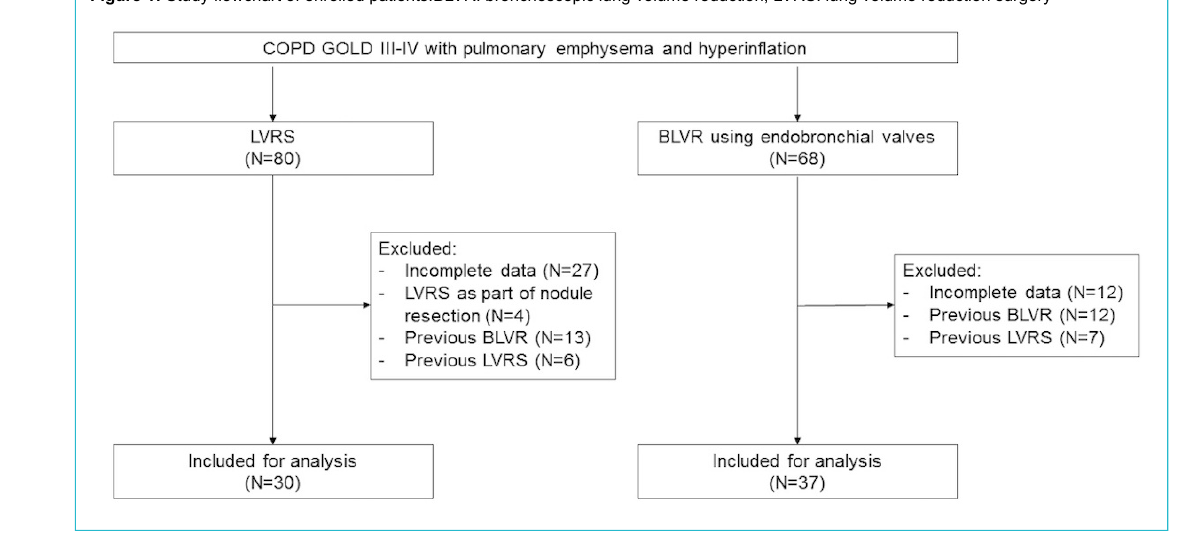
Figure 1: Study flowchart of enrolled patients.BLVR: bronchoscopic lung volume reduction; LVRS: lung volume reduction